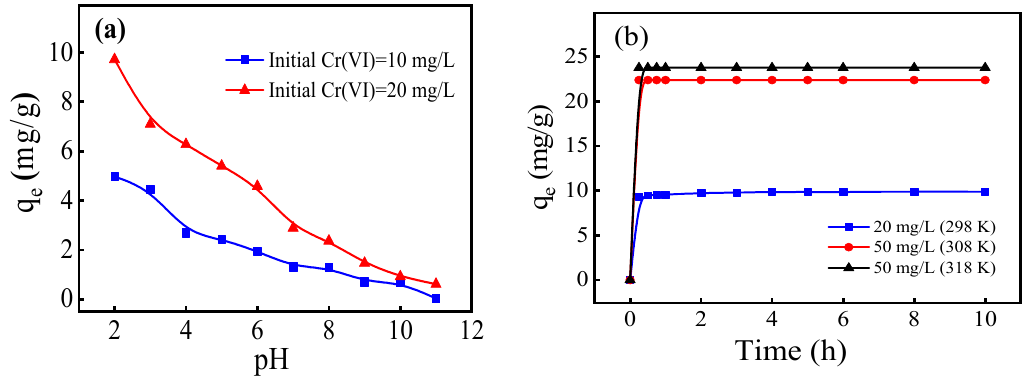
Figure 3. The effect of pH and contact time on Cr(VI) adsorption onto FM-MBC. ( a ) pH, ( b ) contact time.